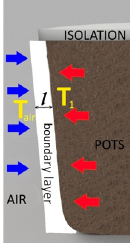
Fig. 1. Geometry of the wall of pot-in-pot with boundary layer and the distribution of the heat fl uxes at static equilibrium.